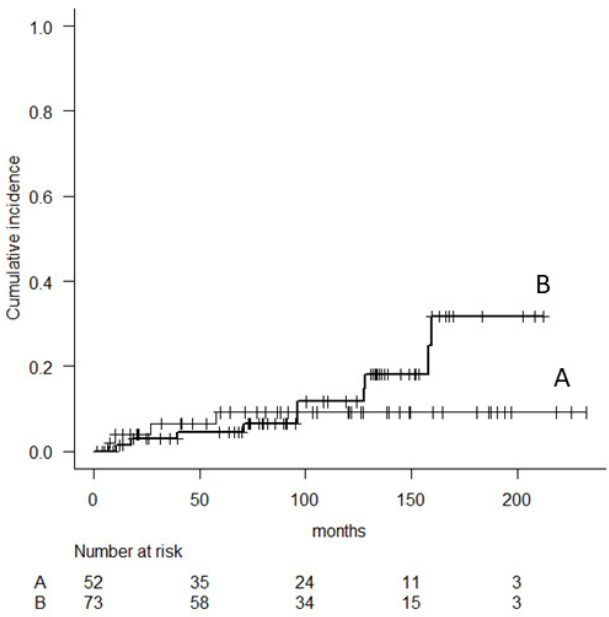
Figure 6. Cumulative risk analysis of implant failure due to stem breakage comparing patients with cement ( A ) and cementless ( B ) femoral stem.